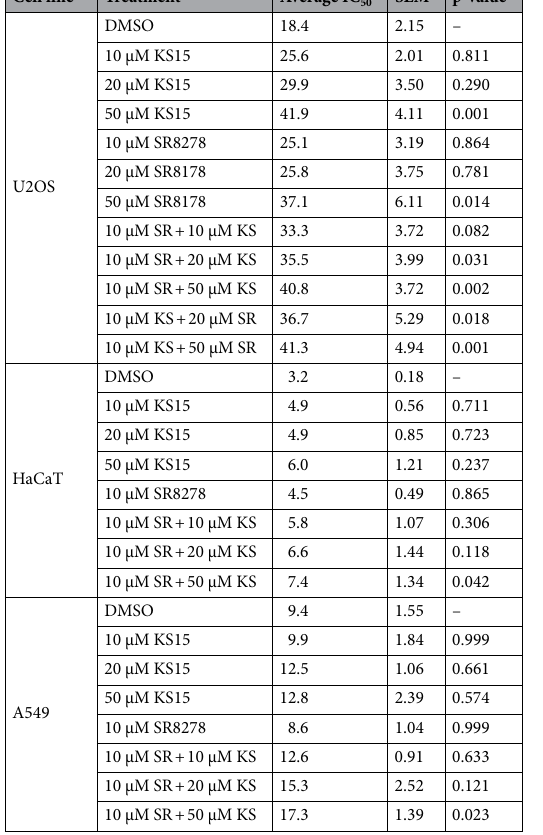
Table 1. Summary of IC 50 values for cisplatin-treated human cells. Non-linear regression was used to calculate IC 50 values for U2OS, HaCaT, and A549 cells treated with cisplatin and the indicated concentrations of KS15 and SR8278 as shown in Figs. 1 and 2. One-way ANOVAs were used to identify KS15 and SR8278 treatment conditions that significantly impacted IC 50 values in comparison to the vehicle (DMSO)-treated